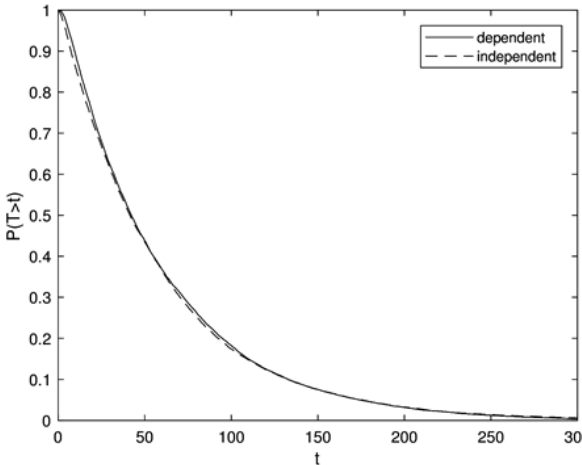
Figure 1: Survival functions for Case 1 and Case 2 when m = 1 and k = 2 .